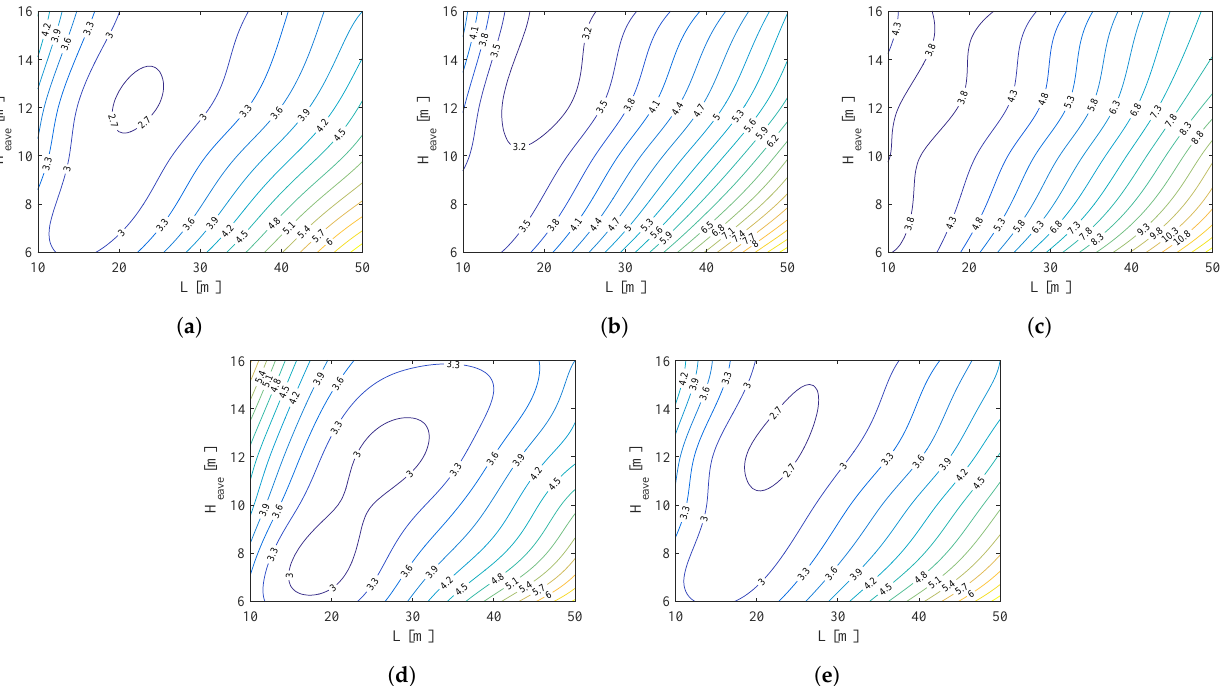
Figure A4. Contours of optimal frame ECI (kgCO 2 /m 3 ) for Model 3: ( a ) Detroit, MI; ( b ) St. Paul, MN; ( c ) Berlin, NH; ( d ) Miami, FL; ( e ) St. Charles,